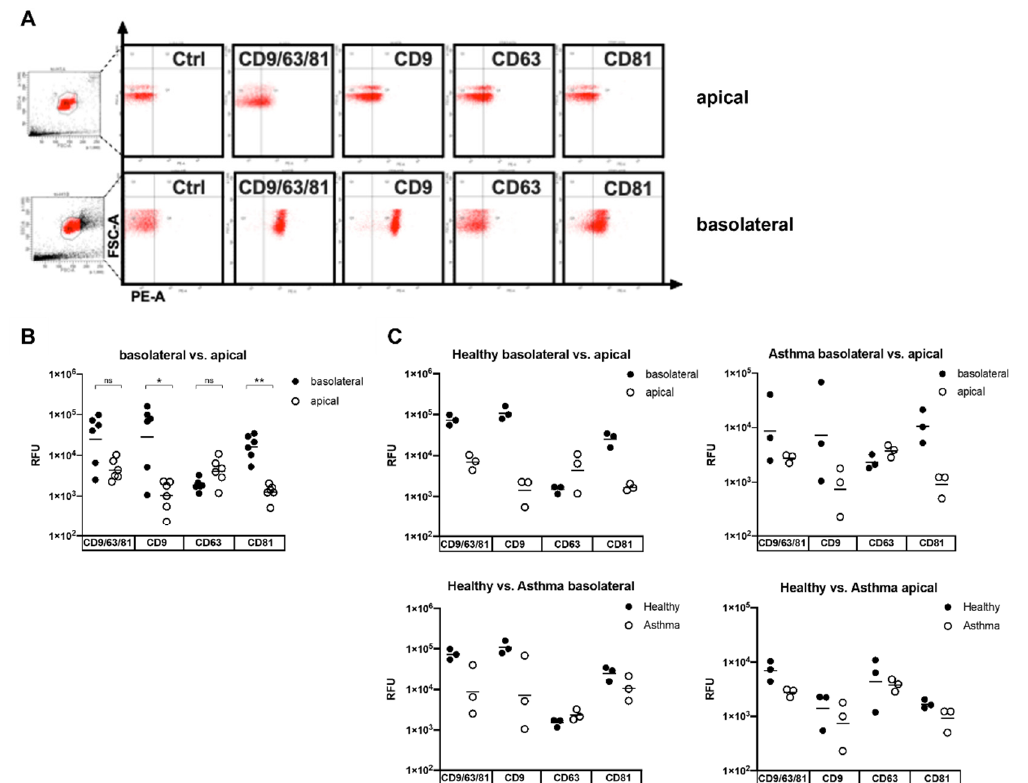
Figure 3. Bead-based flow cytometry analysis of tetraspanins surface marker expression on EVs released by airway epithelial cells. Vesicles were captured using beads coated with a mixture of CD9-, CD63-, and CD81-specific antibodies. Specific secondary antibodies coupled with either CD9, CD63, or CD81, or a combination of all three, were used for detection. ( A ) The results of one representative experiment demonstrating tetraspanin expression on EVs isolated from apical and basolateral cell culture medium are shown. ( B ) Tetraspanin expression in EVs isolated from basolateral versus apical cell culture medium regardless of disease expression. ( C ) Comparison of the surface marker expression of apical and basolateral EVs in healthy and asthmatic subjects. n = 3 in each group, * p < 0.05, ** p < 0.01. EV—extracellular vesicle; ns—not significant; RFU—relative fluorescent units.